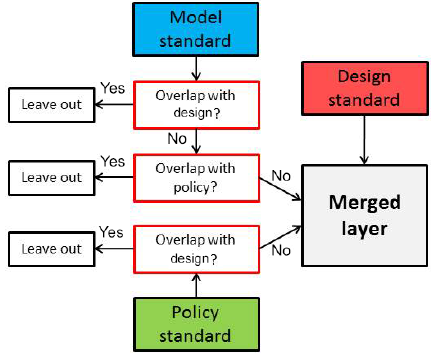
Figure 1. Hierarchical structure of information contained in the FLOPROS database. The design layer provides information on the construction standard of existing protection measures; the policy layer is relative to normative standards of protection; while the model layer calculates protection using flood hazard modelling and a relationship between wealth and flood protection (see Sect. 2.4 for details). These are aggregated into the merged layer, as explained in Sect. 2.